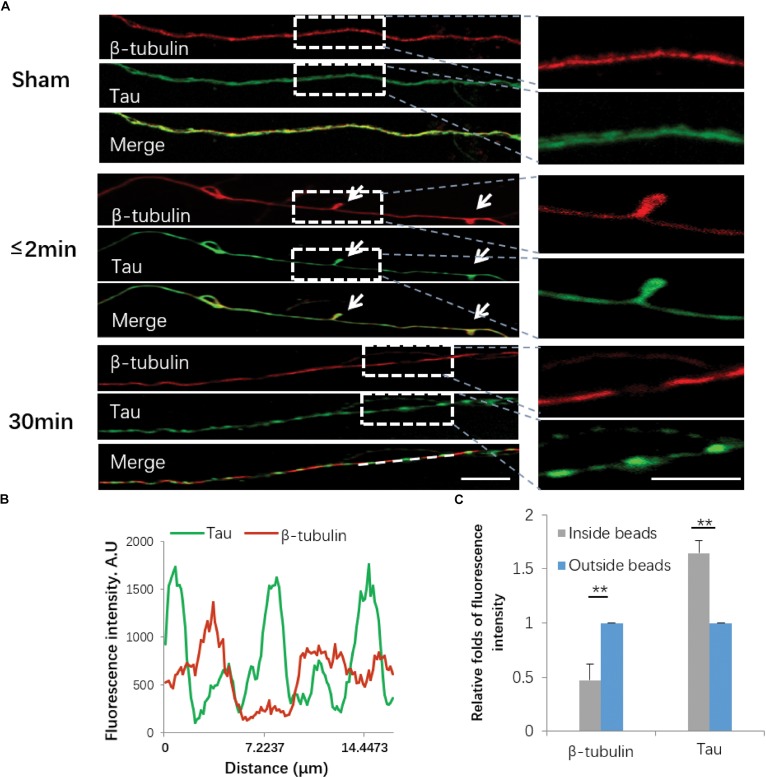
Immunofluorescence of cytoskeletal components following stretch. (A) Axons with or without stretch injury showed a distinctive expression pattern of both β-tubulin (red) and Tau (green). White arrows indicate immediate emergence of undulation (≤2 min) after stretch (white arrows). Representative images on the right show the white rectangle areas within the left images under high magnification. (B) Quantification of line scanning results within the marked area (white line). (C) Quantitative analysis for the fluorescence intensities of tubulin and Tau within and outside of the spheroids 30 min post-stretch (all data were presented as mean ± SE; paired-samples t-test, ∗∗P < 0.01; n = 7). Scale bar = 10 μm.